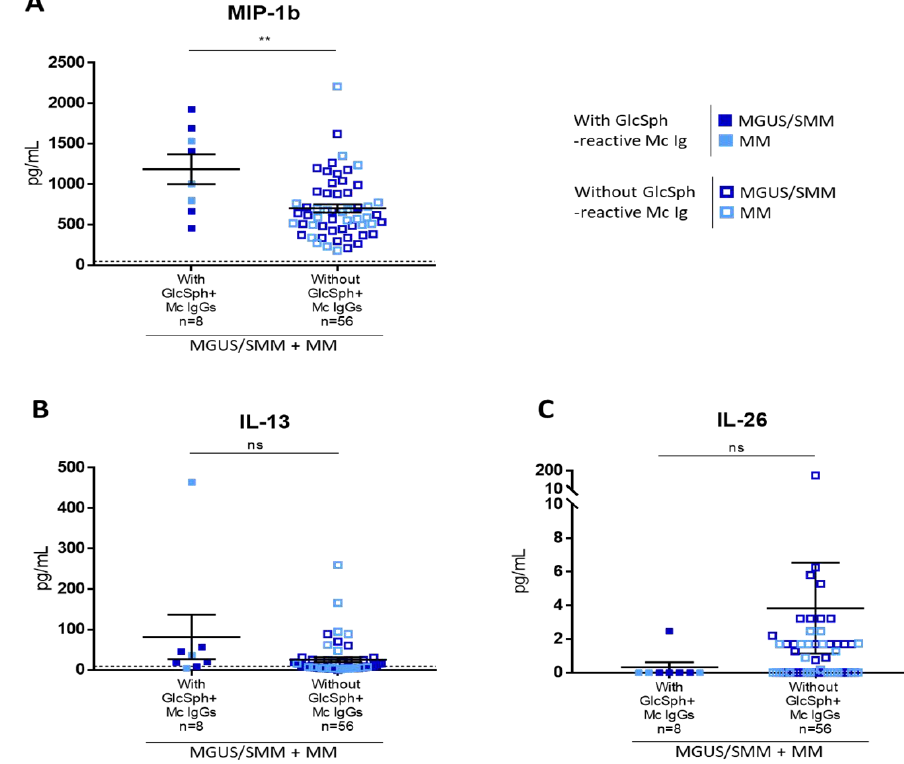
Figure 6. Differences in cytokine levels according to the presence of a GlcSph-reactive monoclonal Ig for MGUS/SMM and MM patients. The levels of MIP-1 β ( A ) were significantly different depending on the presence of a monoclonal GlcSph-reactive IgG, whereas the levels of IL-13 ( B ) and IL-26 ( C ) were not. Each figure has a different scale. Bars indicate means + SEM. MGUS/SMM ( ) and MM ( ) patients with a GlcSph-reactive monoclonal (Mc) IgG; MGUS/SMM ( ) and MM ( ) patients without a GlcSph-reactive Mc IgG. (**) p < 0.01, Mann – Whitney t -test. The dotted line represents the maximal normal value observed in healthy individuals. NS: not significant.